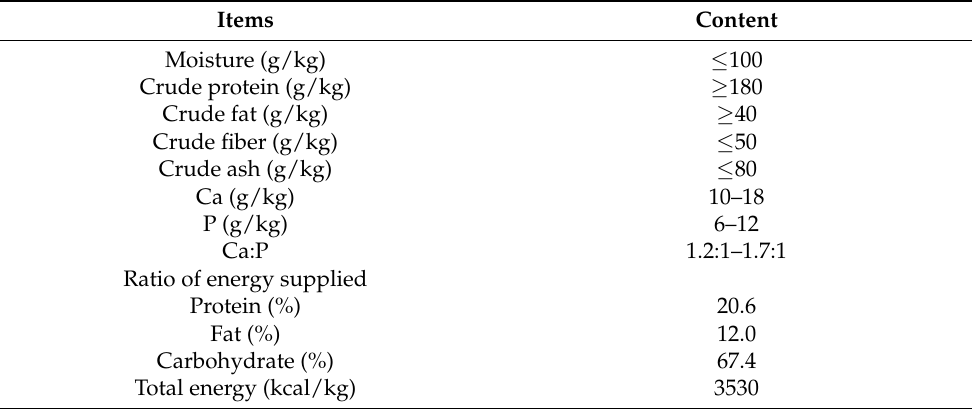
Table 2. Nutrient composition of